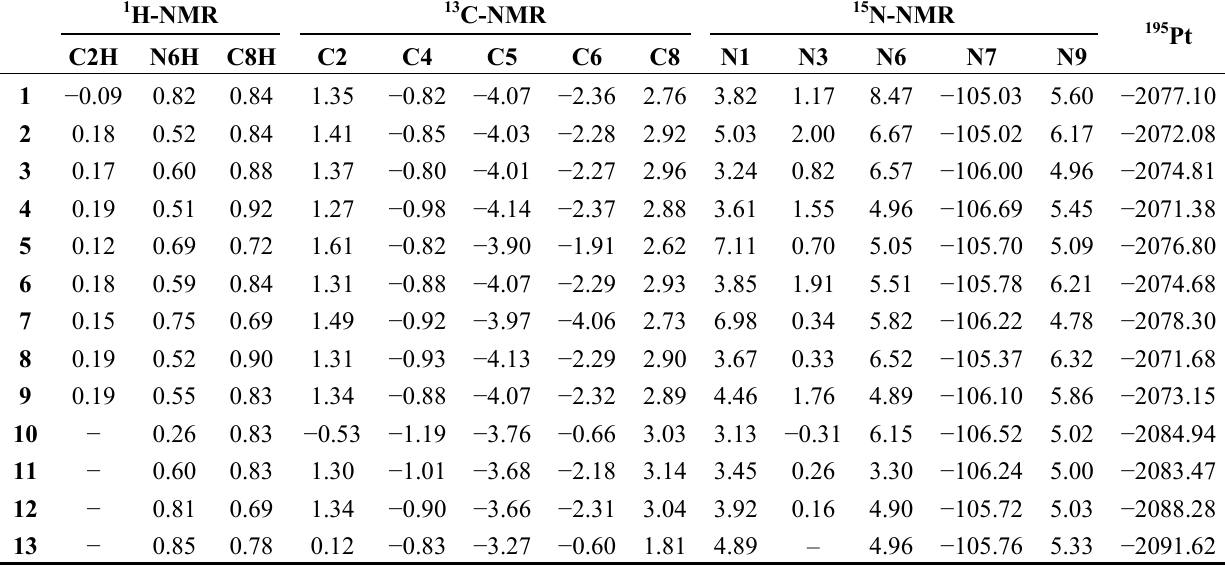
Table 1. The 1 H-, 13 C- and 15 N-NMR coordination shifts ( ∆ δ = δ selected atoms and 195 Pt chemical shifts ( δ ; ppm) of the prepared